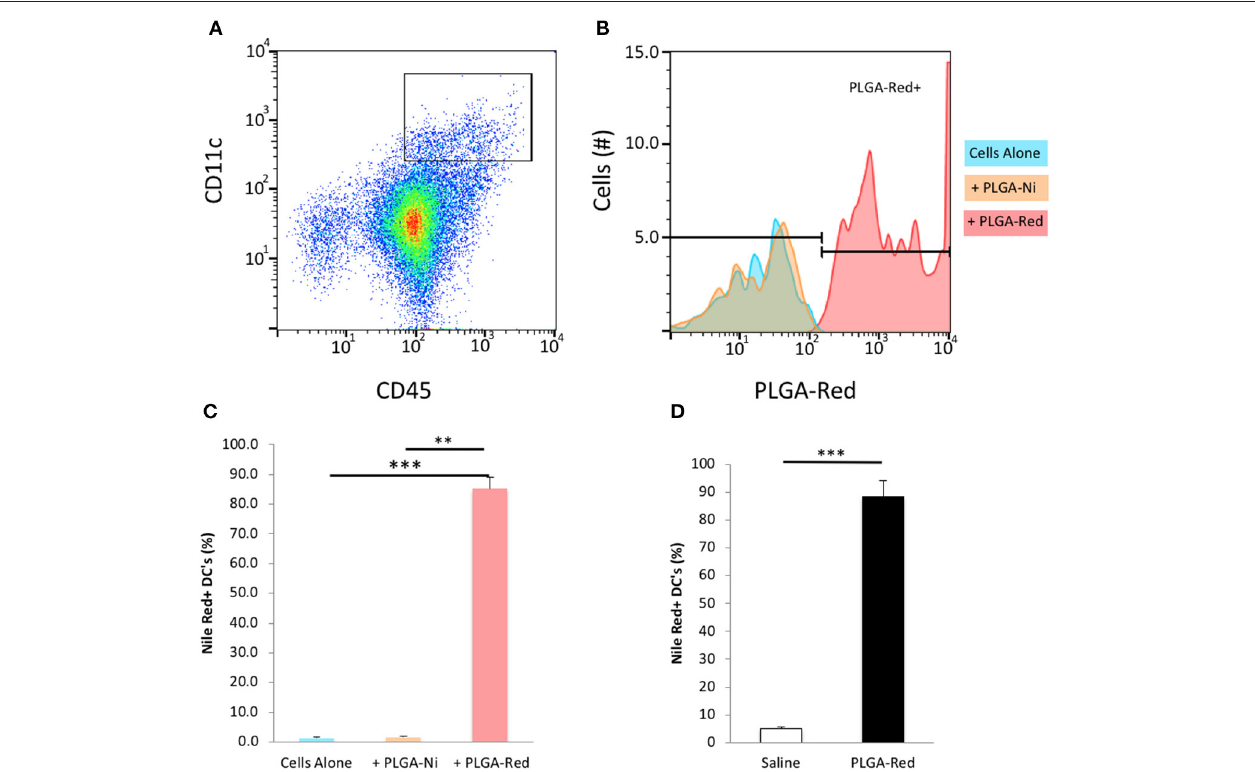
FIGURE 3 | Microparticle uptake by DC in vitro and in vivo . Single cell suspensions of freshly isolated splenocytes were incubated with PLGA-Ni, PLGA-Red, or saline vehicle in vitro for 18h. (A) Flow cytometry-identified CD45 + CD11c + splenic DC were evaluated (B) for PLGA-Red microparticle uptake with PE fluorochrome settings. Saline (blue) and PLGA-Ni (orange) treatment populations showed similar PE signal indicating PLGA-Ni alone had low-to-no autofluorescence. PLGA-Red (red) treated DC showed PE signal which when quantified (C) displayed a 85% uptake of microparticles ( n = 10 wells). PLGA-Red uptake was significant compared to the other treatment groups (Kruskal-Wallis test) with p -values of 0.0001 (saline vs. PLGA-Red) and 0.0026 (PLGA-Ni vs. PLGA-Red). PLGA-Red particles alone did not exhibit signal in DC marker fluorochrome channels (data not shown). (D) PLGA-Red microparticles were administered subcutaneously in mice and DC were isolated from a 1 cm 2 patch of skin 18h later. DC from the skin patch of PLGA-Red treated animals exhibited a 88.5% uptake of microparticles ( n = 5 mice, Student t -test p = 0.0001). Experiments were performed twice in mice from separate NOD cohorts. Statistical significance is designated with ** if p < 0.01 and *** if p =